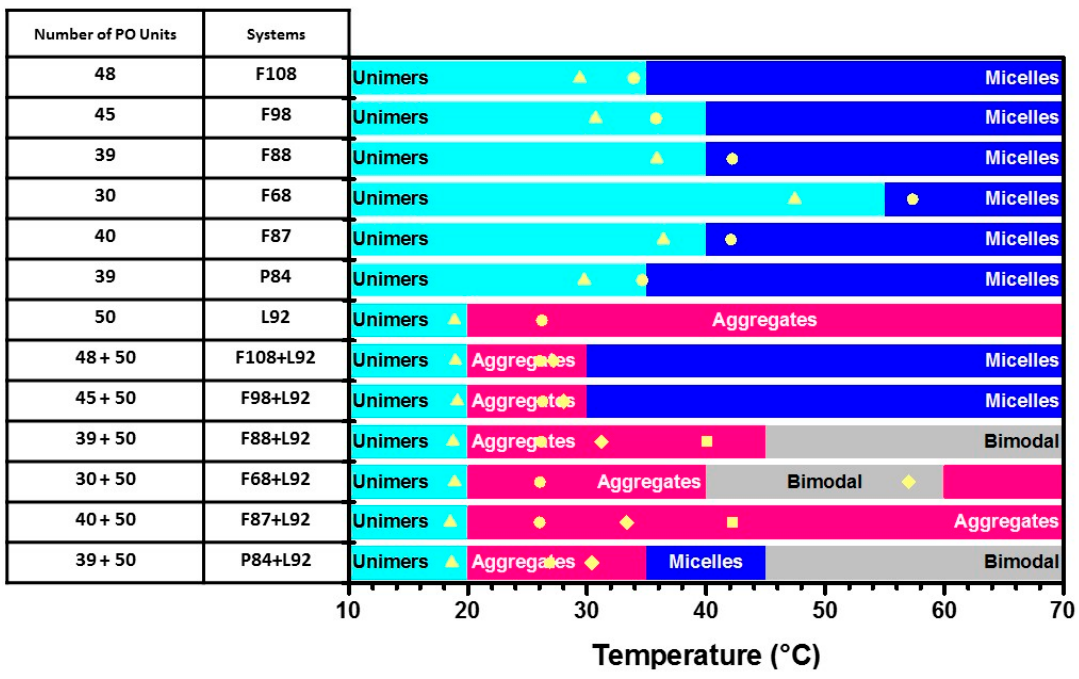
Figure 6. The evolution of self-assembly behavior of pure and mixed Pluronic L92 + Fx8 and L92 + F8x systems as a function of temperature. Symbols on the stacking bars represent characteristic temperatures measured by HSDSC. For pure Pluronic systems, T onset (yellow triangle) and T m (yellow circle) of the endothermic peak in the HSDSC thermograms. For the mixed Pluronic systems, T onset (yellow triangle) of the first endothermic peak, T m (yellow circle) of the 1st peak, T m2 (yellow diamond) of the 2nd peak, and T m3 (yellow square) of the 3rd peak in the HSDSC thermograms.